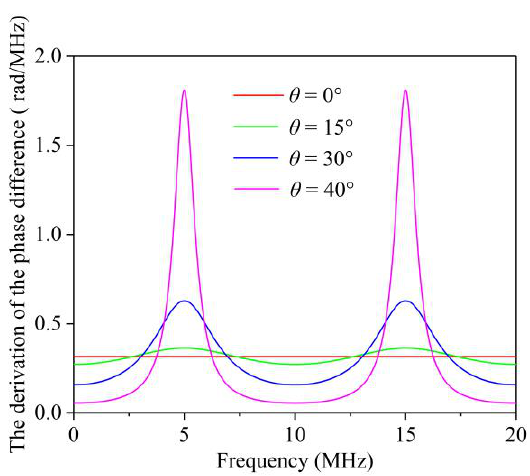
Figure 2. An illustration of the derivation of the phase difference .